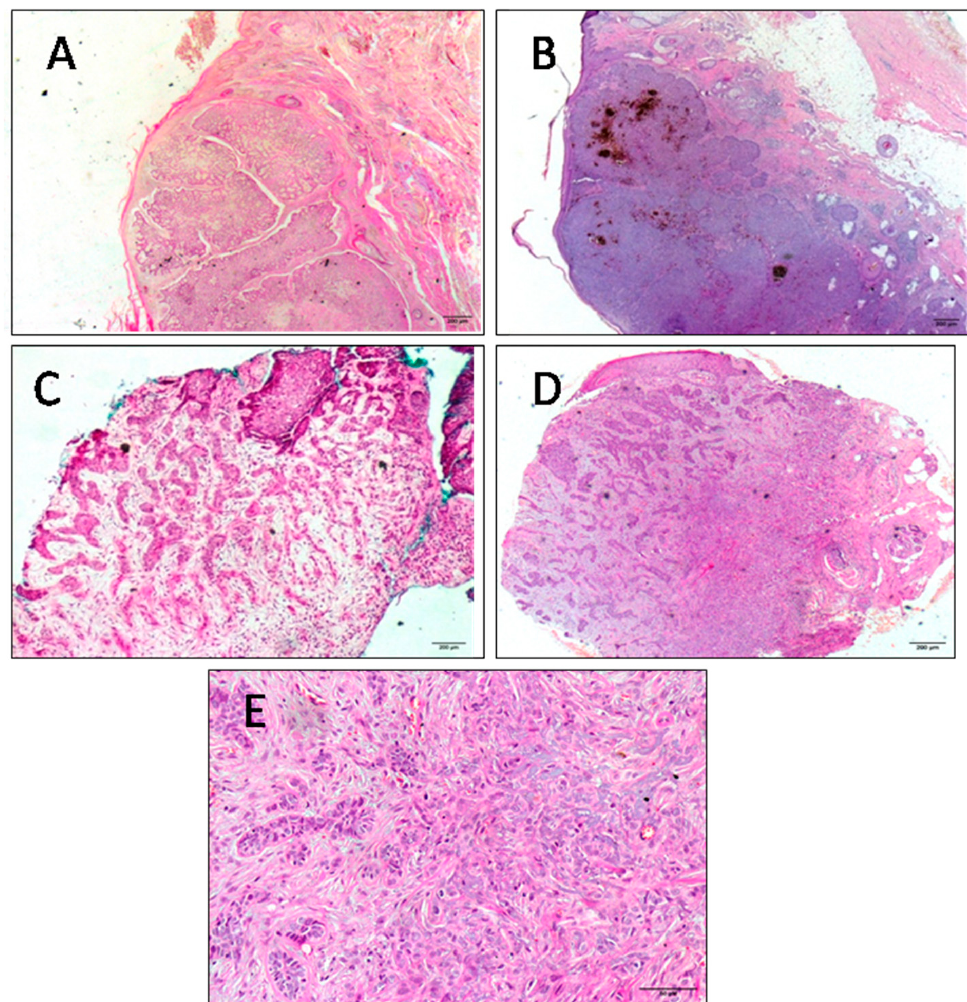
Figure 2. Hematoxylin-and-eosin-stained section of BCC tumor tissues representative of different histopathological subtypes of BCC. ( A ) Adenoid basal cell carcinoma with pseudo-glandular ap- pearance. The stroma is fibrous ( × 100). ( B ) Nodular subtype of basal cell carcinoma with melanin deposit ( × 100). ( C ) Morphea form basal cell carcinoma with narrow cords of basaloid cells which are compressed by abundant sclerotic collagenous stroma ( × 100). ( D ) Basosquamous basal cell carcinoma ( × 100). ( E ) A focal squamous differentiation ( × 200). Scale bars = 200 µ m for ( A – D ) and 50 µ m for ( E